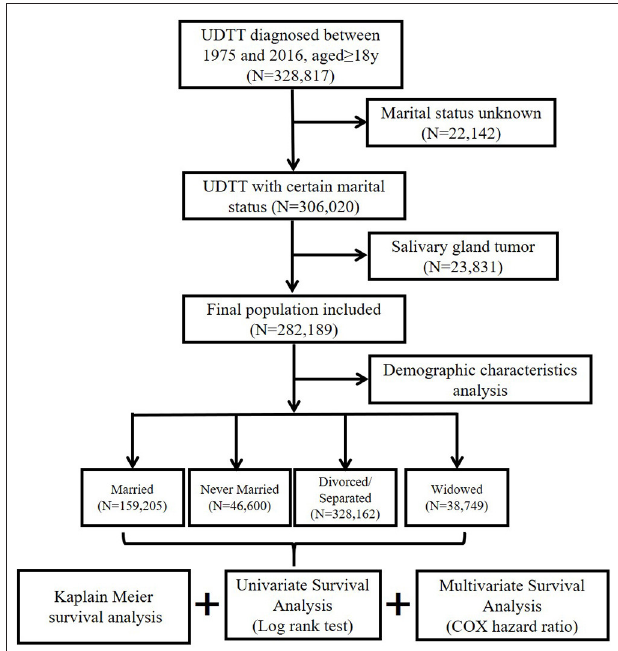
FIGURE 1 | Eligibility criteria for collection of patients with